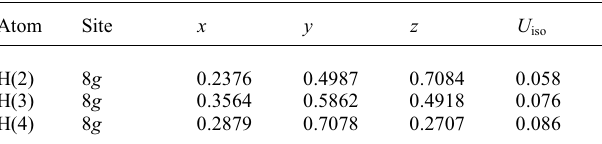
Table 3. Atomic coordinates and displacement parameters (in Å 2 ) .